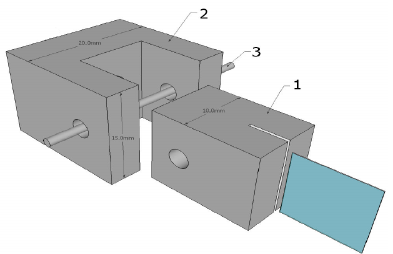
Figure 1. Schematic drawing of the mounting setup. Part 1 is a 3D-printed clamp in which the polymer is glued. Part 2 is a 3D-printed mounting base attached to the tensile machine. Parts 1 and 2 are held together with pin